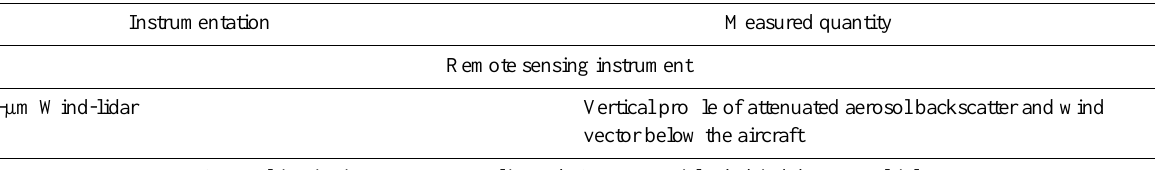
Table 1. Falcon instrumentation for the DLR volcanic ash missions in April/May